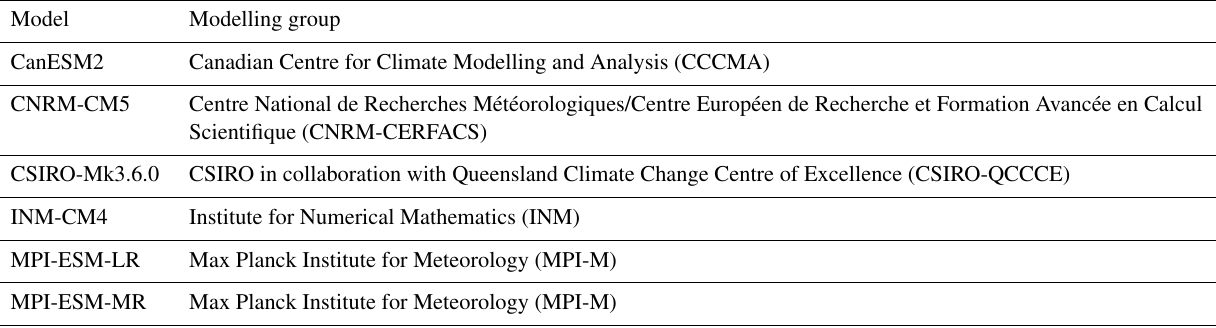
Table 1. List of CMIP5 models used in this study and their institution.